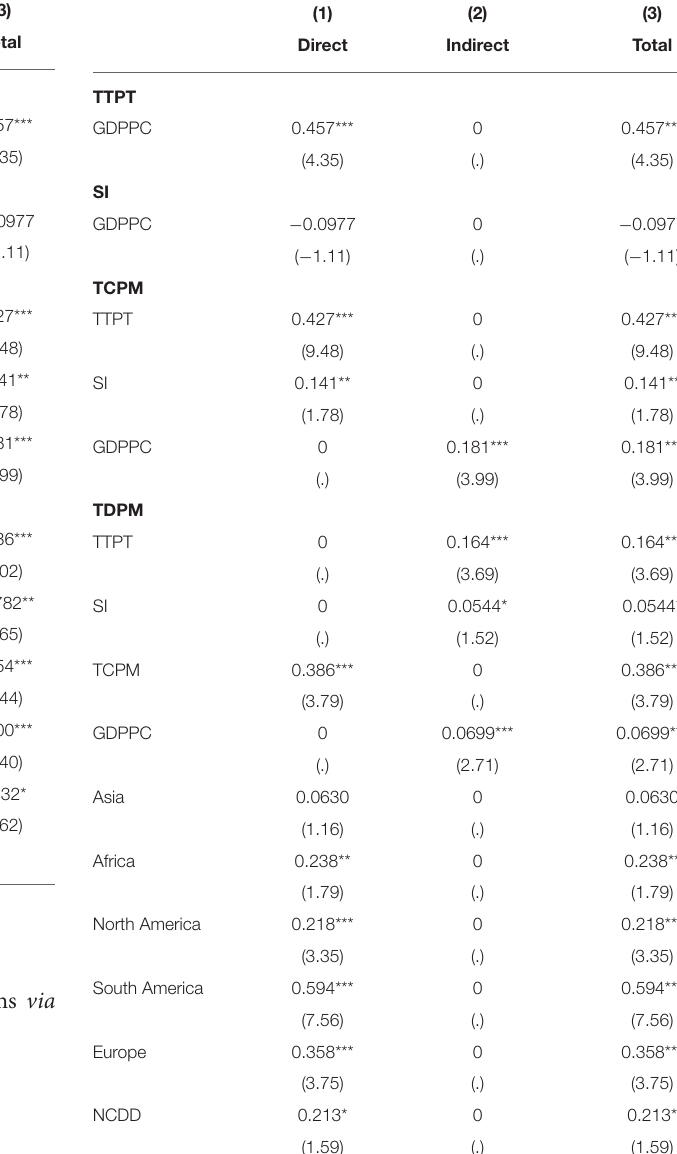
TABLE 9 | Direct, indirect, and total effects of the determinants of COVID-19 deaths via NCDD without dummies.